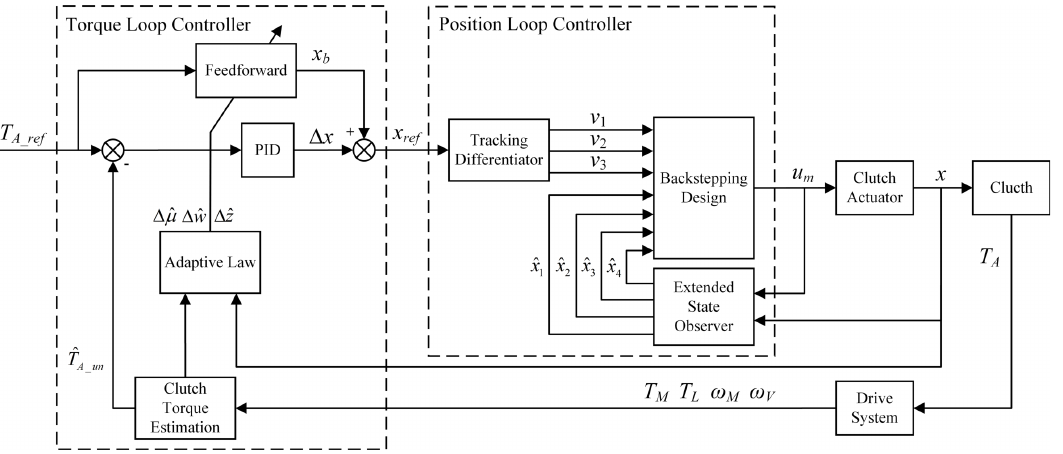
Figure 8. Schematic diagram of the double-loop